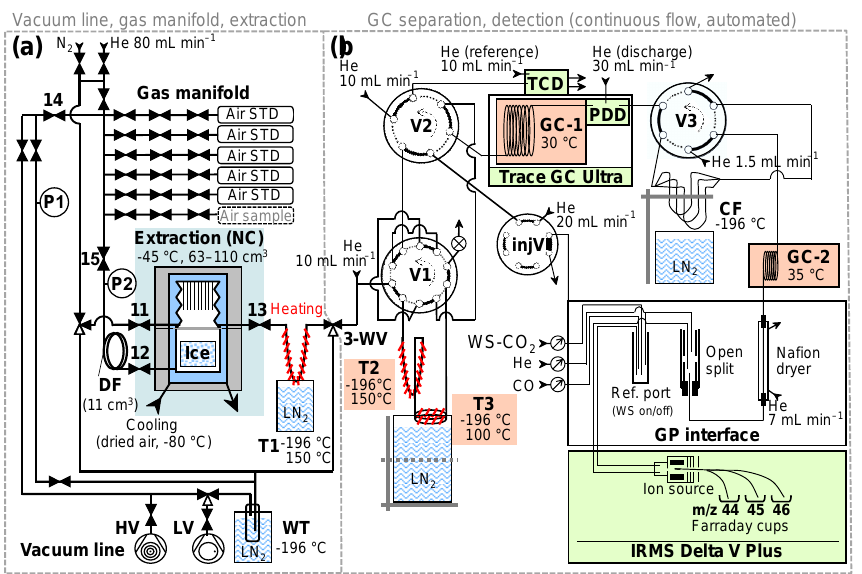
Figure 2. Schematic representation of the new analytical CIC system for simultaneous measurements of CO 2 mixing and stable isotope ratios. The set-up consists of a manually operated section A, allowing injection and loading of air and ice samples, and a fully automated section B, for gas separation, purification and final detection run in continuous flow mode. Highlighted in red and green are components for gas separation and detection, respectively. See main text for details (Sects. 2 and